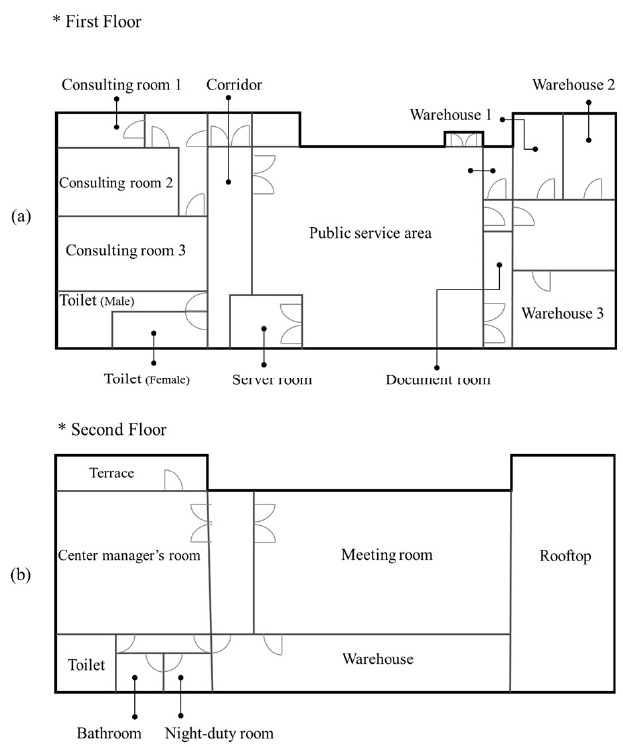
Figure 3. Space utilization in the office building, ( a ) first floor and ( b ) second